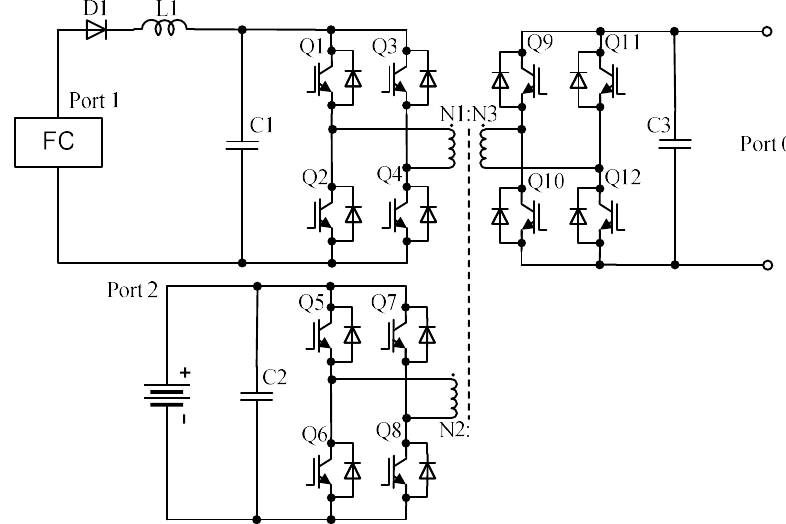
Figure 15. Isolated Three-Port Bi-Directional DC-DC Converter [74].